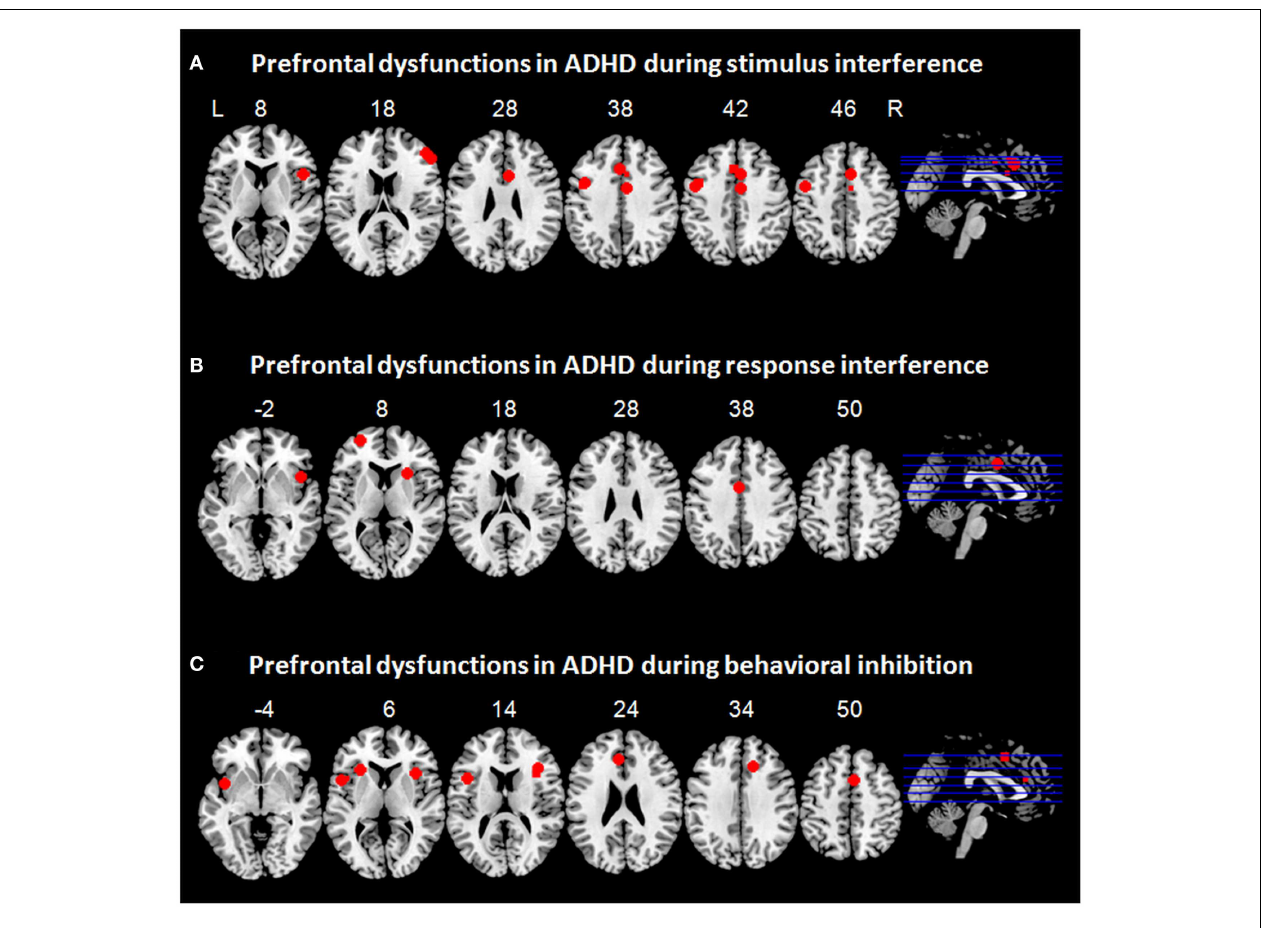
Braver (2010), Bush et al. (1999), Cubillo et al. (2010, 2011), Epstein et al. (2007), Hart et al. (2013), and Sebastian et al. (2012). Blue, prefrontal dysfunctions associated with emotionally neutral impulse control. L = left; R =